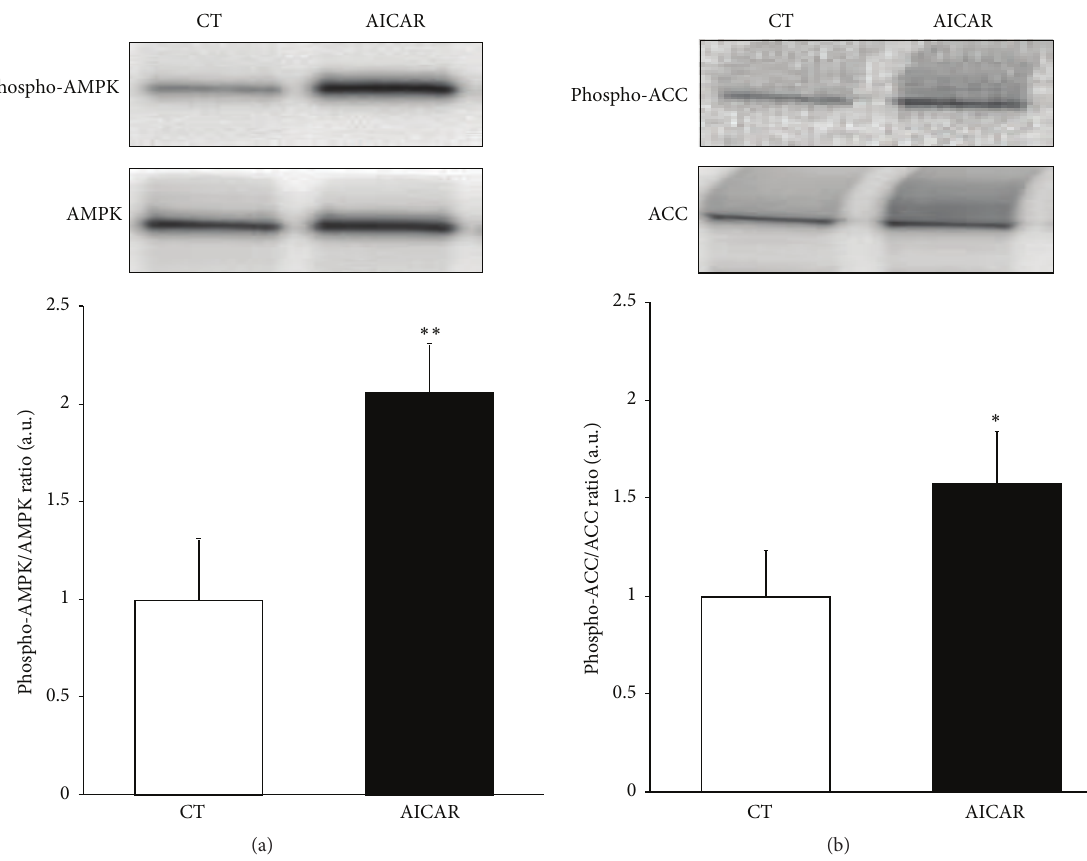
Figure 1: AICAR induces AMPK activation in HL-1 cardiac cells. HL-1 cells were stimulated with AICAR for 1h and the AMPK activation was confirmed by the protein levels of phospho-Thr 172 -AMPK (a) and phospho-Ser 79 -ACC (b). Quantifications show the ratio between phosphorylated and total forms of each protein. Data are expressed as mean ± SD of 3 different experiments. ( ∗ 𝑃 < 0.05 , ∗∗ 𝑃 < 0.01 versus control nonstimulated